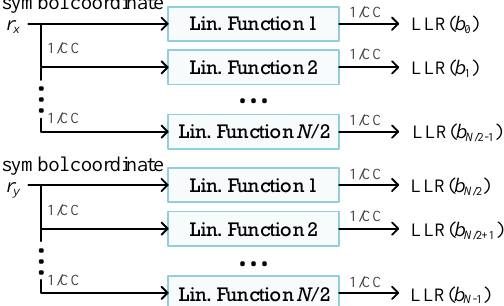
Figure 3. M -QAM demodulation architecture of the piecewise log likelihood ratio (PLLR)